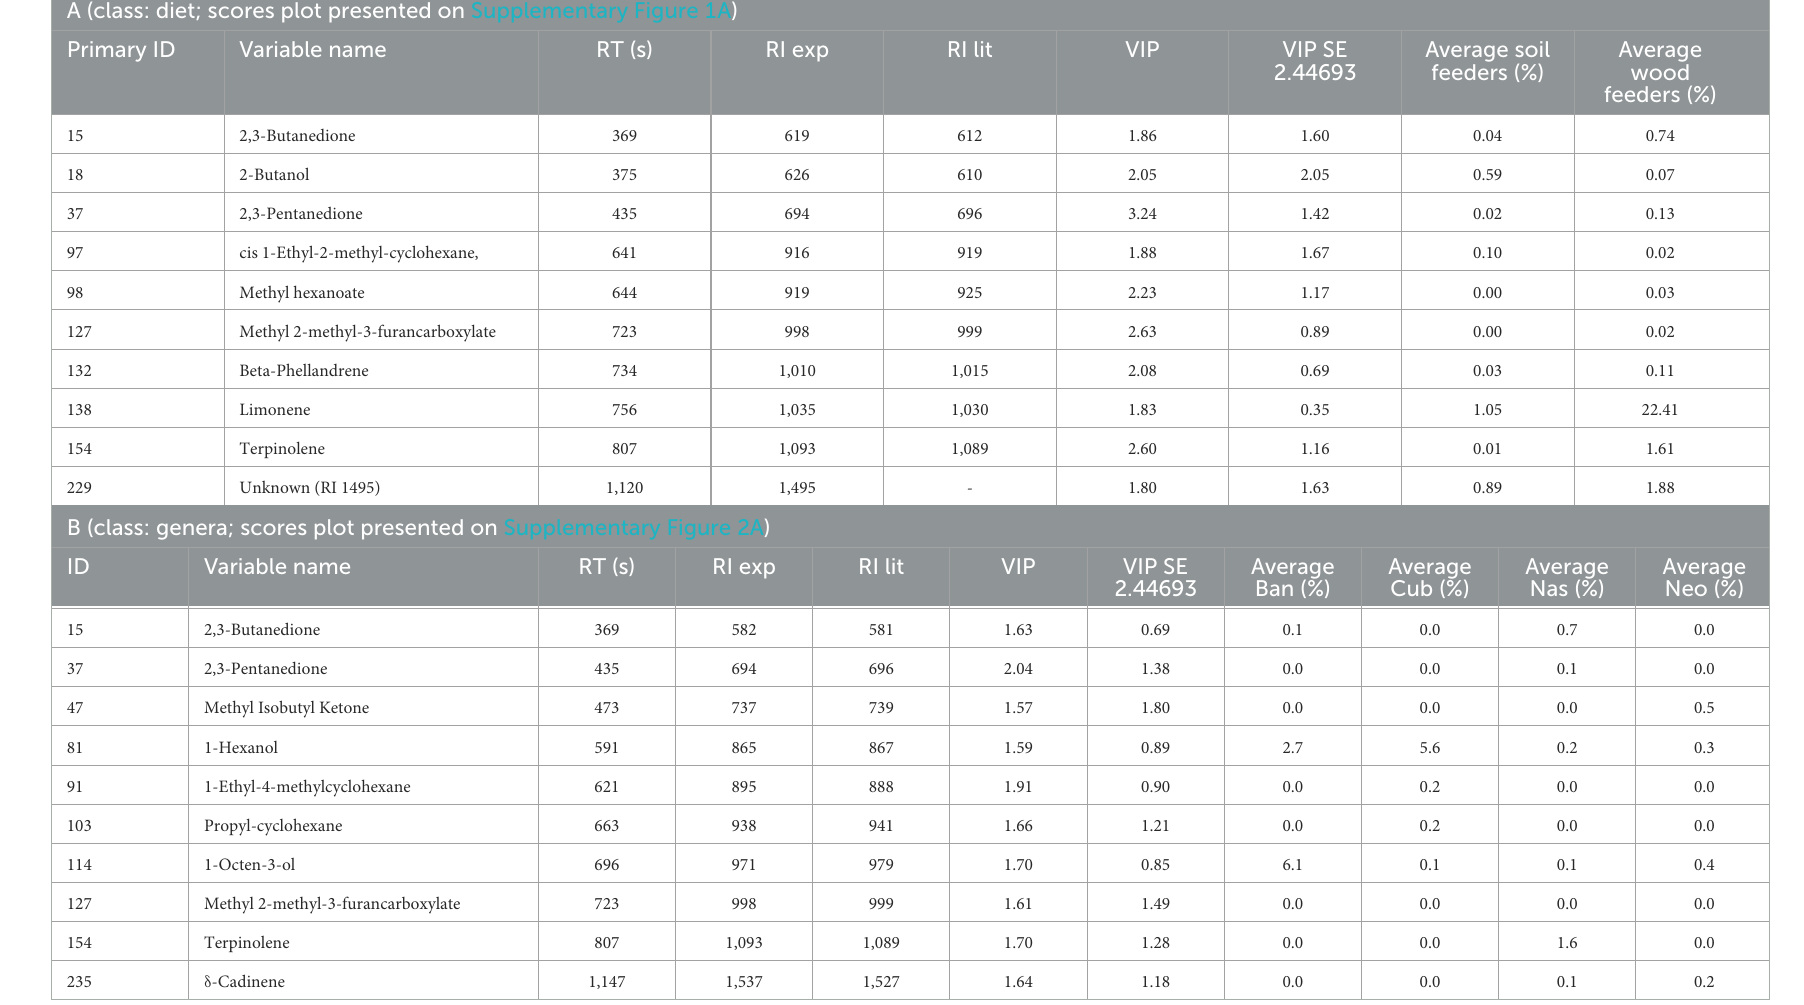
TABLE 2 Ten most decisive analytes from PLS-DA analysis (Supplementary Figures 1, 2) selected according to VIP. A (class: diet; scores plot presented on Supplementary Figure